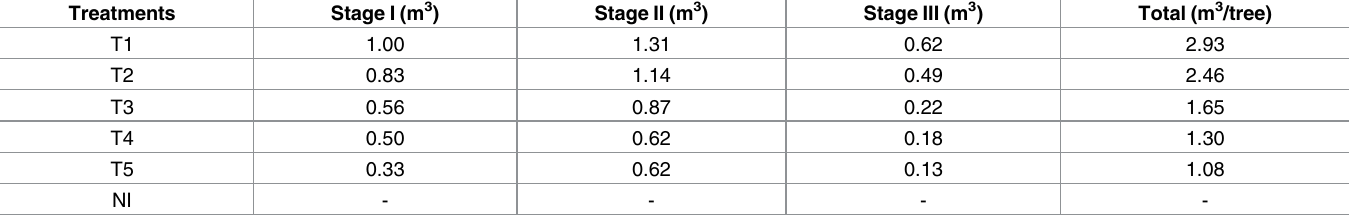
Table 2. Irrigation water applied (mm) in six treatmentsin the experimental mango orchard from fruit set stage (stage I), fruit rapid expanding stage (stage II), fruit maturation stage (stage III) and seasonal (total).